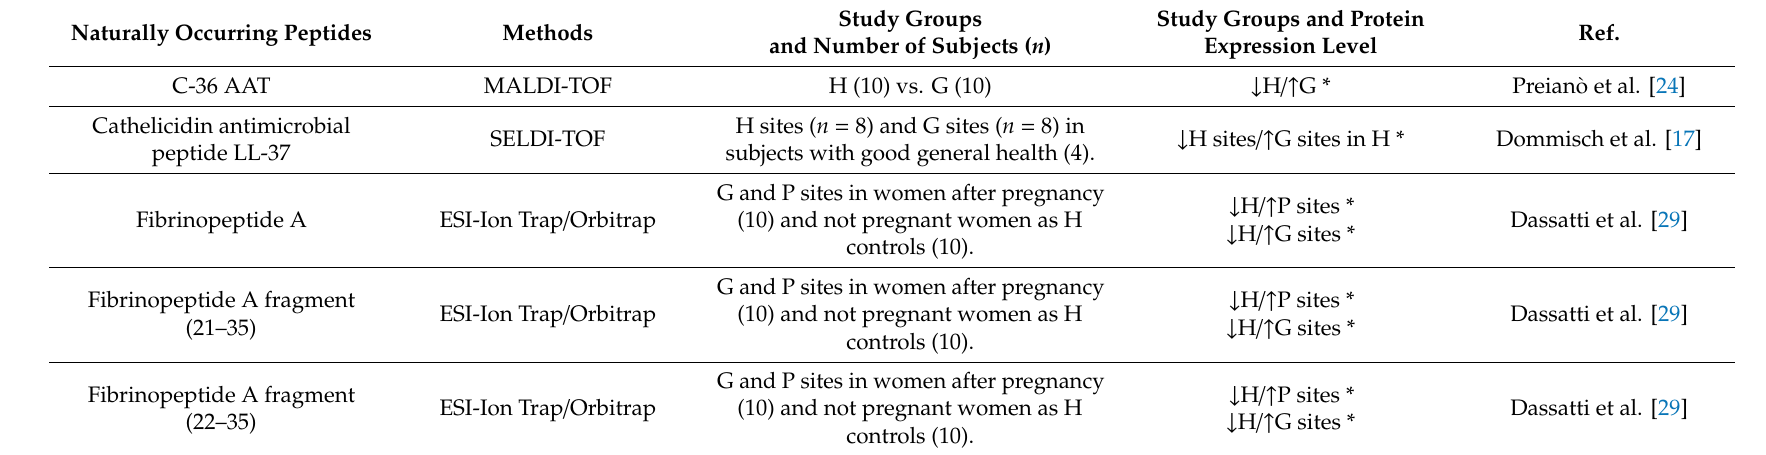
Table 2. Naturally occurring peptides found in gingival crevicular fluid (GCF) from di ff erent study groups. Expression levels are shown as increased ( ↑ ) or decreased ( ↓ ), as determined by the referred investigation in relation to the appropriate control group. H = Healthy, G = Gingivitis, P = periodontitis, CP = Chronic